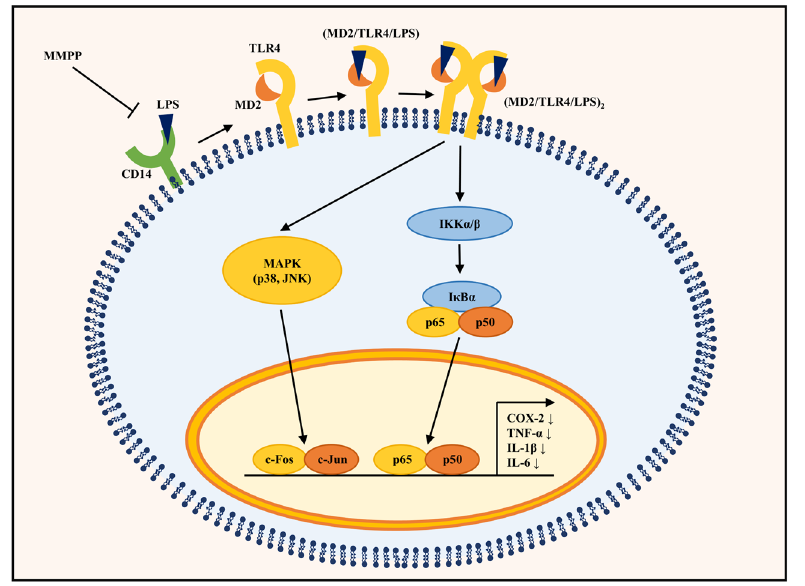
Figure 6. Schematic diagram of the effect of MMPP on the LPS-stimulated THP-1 cells. LPS binding to TLR4 is facilitated by CD14 and MD2. The binding of MMPP to CD14 and MD2 was revealed through molecular docking analysis and in vitro binding assay. MMPP treatment alleviated the phosphorylation of JNK and IKK αβ /I κ B α and the nuclear translocation of NF- κ B p50 and c-Jun, and it finally inhibited pro-inflammatory cytokines and inflammatory mediators such as TNF- α , IL-1 β , IL-6, and COX-2.